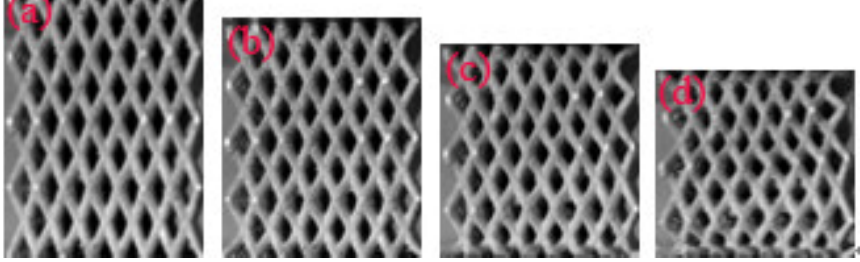
Figure 11. Typical deformation of the pyramid lattice material with a relative density of 0.41 at a strain of ( a ) 2.6%; ( b ) 10%; ( c ) 20%; ( d ) 30%. The average crushing force is given by: